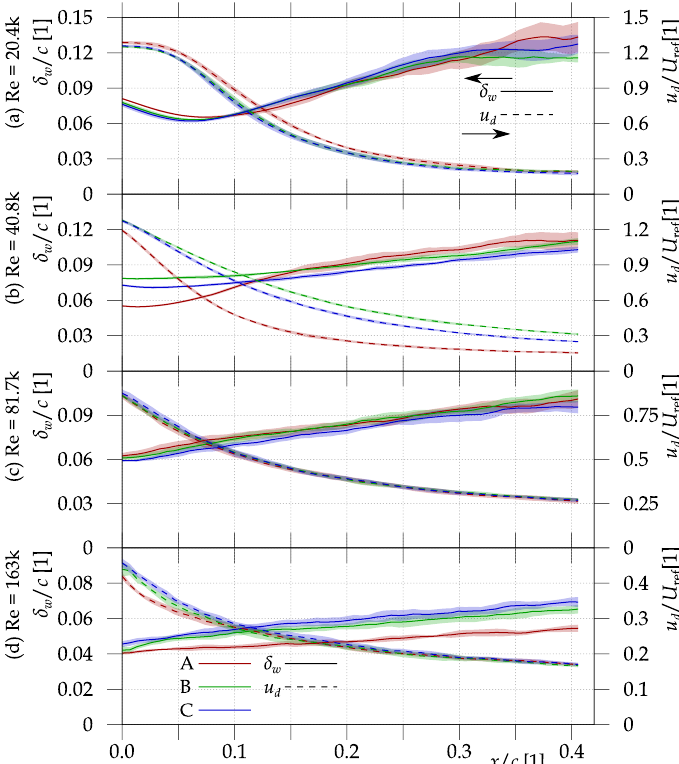
Figure 11. Solid lines indicate the wake width as a function of distance past the airfoil trailing edge, x ; the corresponding axis is on the left-hand-side of the plots. Dashed lines represent the maximum deficit velocity as a function of x ; the axes for these values are on the right-hand-side of the plots. Different panels contain data at different Reynolds numbers and angle of attack α = 0 ◦